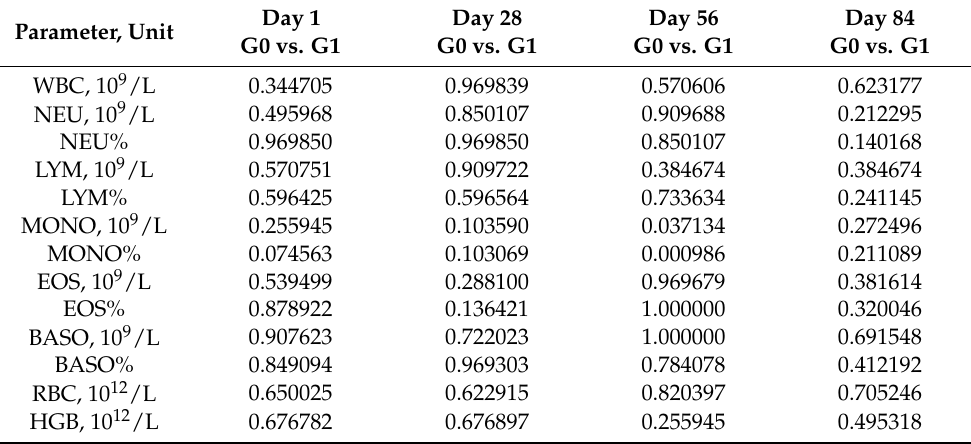
Table 1. p -values representing differences between the supplemented (G0) and control group (G1) in a blood hematological